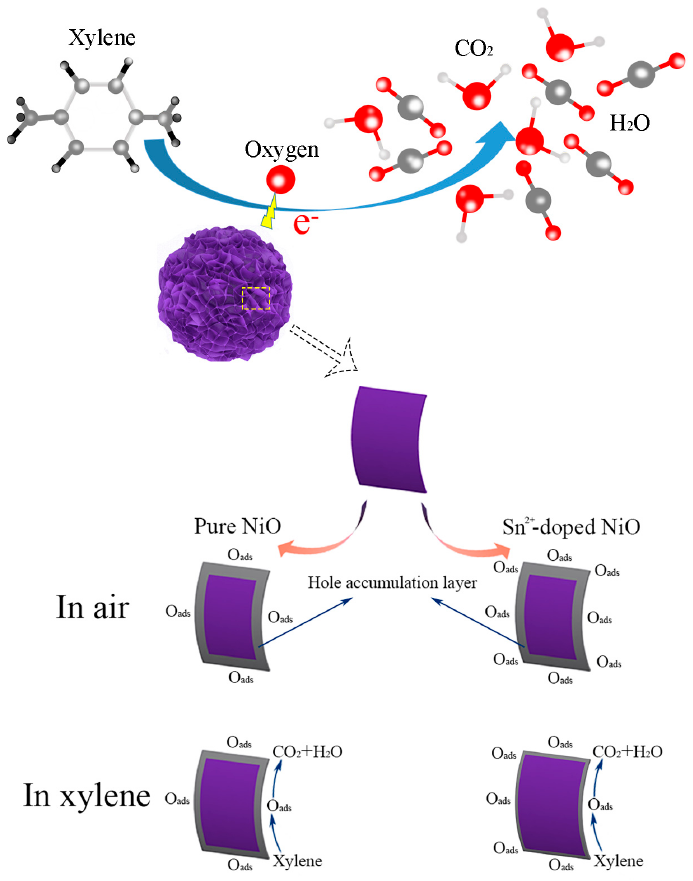
Figure 10. A schematic diagram of the proposed reaction mechanism of the SNM-8 sensor in air and in xylene, respectively.